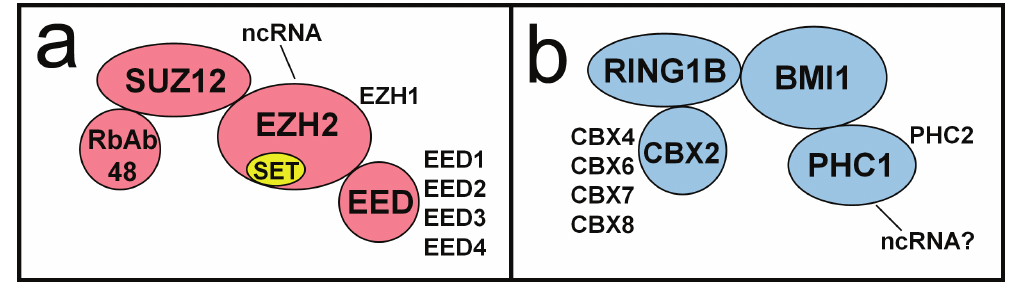
Figure 3. The core components of human polycomb repressive complexes are shown. Some alternate components are shown beside their more common canonical